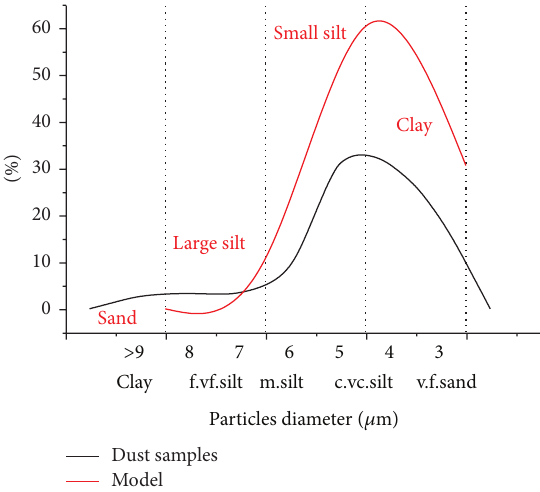
Figure 18: Comparison between the polymodal textures fraction form the Aeolian dust samples in the Island of Gran Canaria and the model results of dry deposition fraction on 3 March 2004 at 18